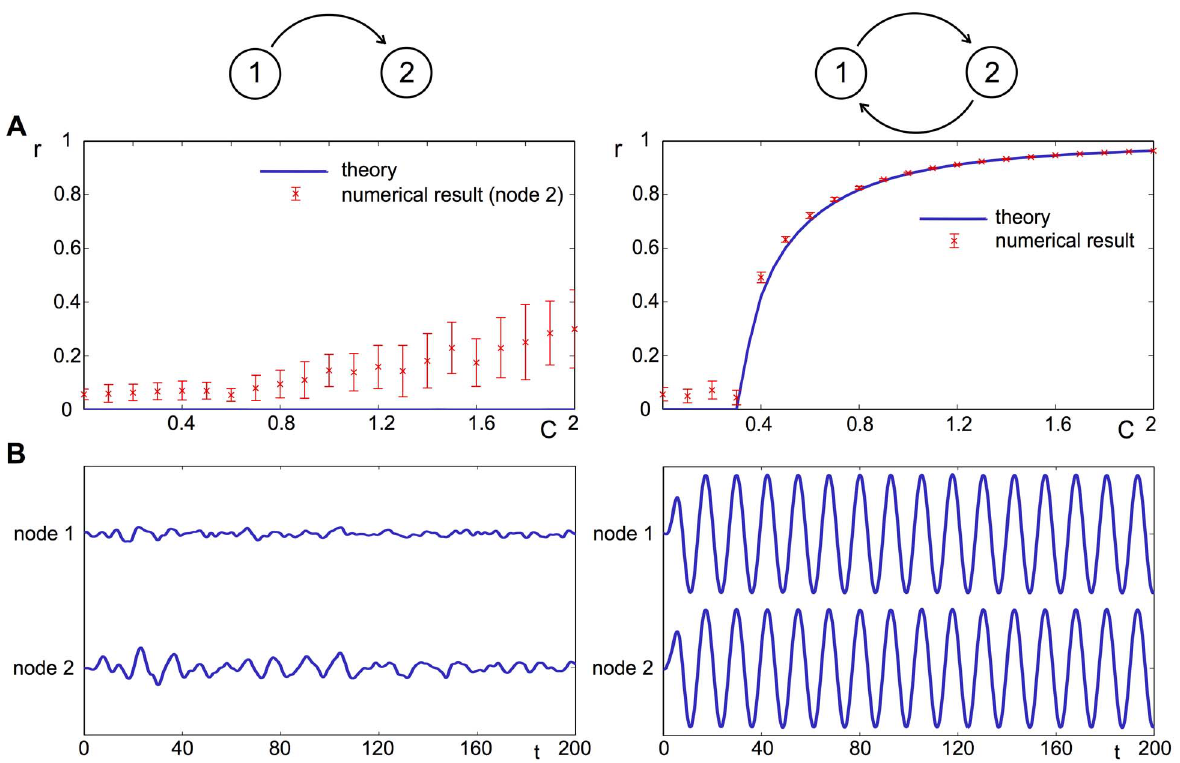
Figure 5. Model behavior on a two-node network. A : The order parameter r for unidirectional and bidirectional coupling between two nodes plotted against the global coupling parameter C , accompanied by numerical results. The slow increase of the numerical result of r with C for unidirectional coupling is due to the finite size of the system with N ~ 10 3 ocillators. B : The evolution of the signal s ( t ) of each node with random initial conditions and C ~ 1 .